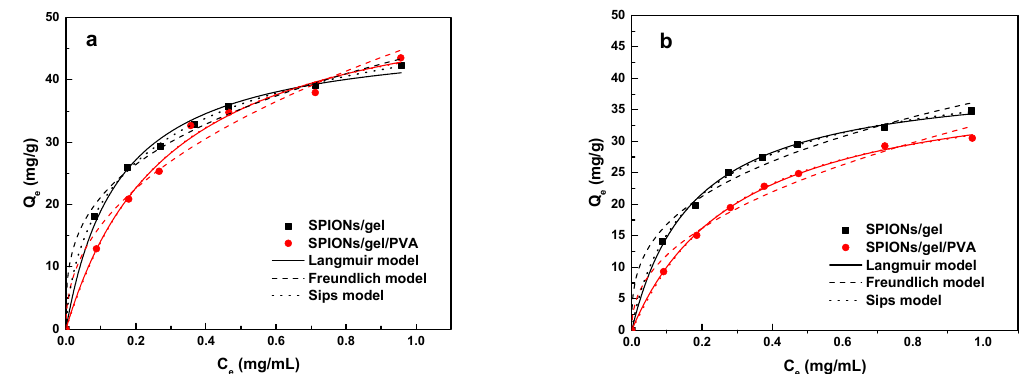
Figure 8. Equilibrium adsorption isotherm of Cu(II) ( a ) and Zn(II) ( b ) by the SPIONs/gel and SPIONs/gel/PVA.